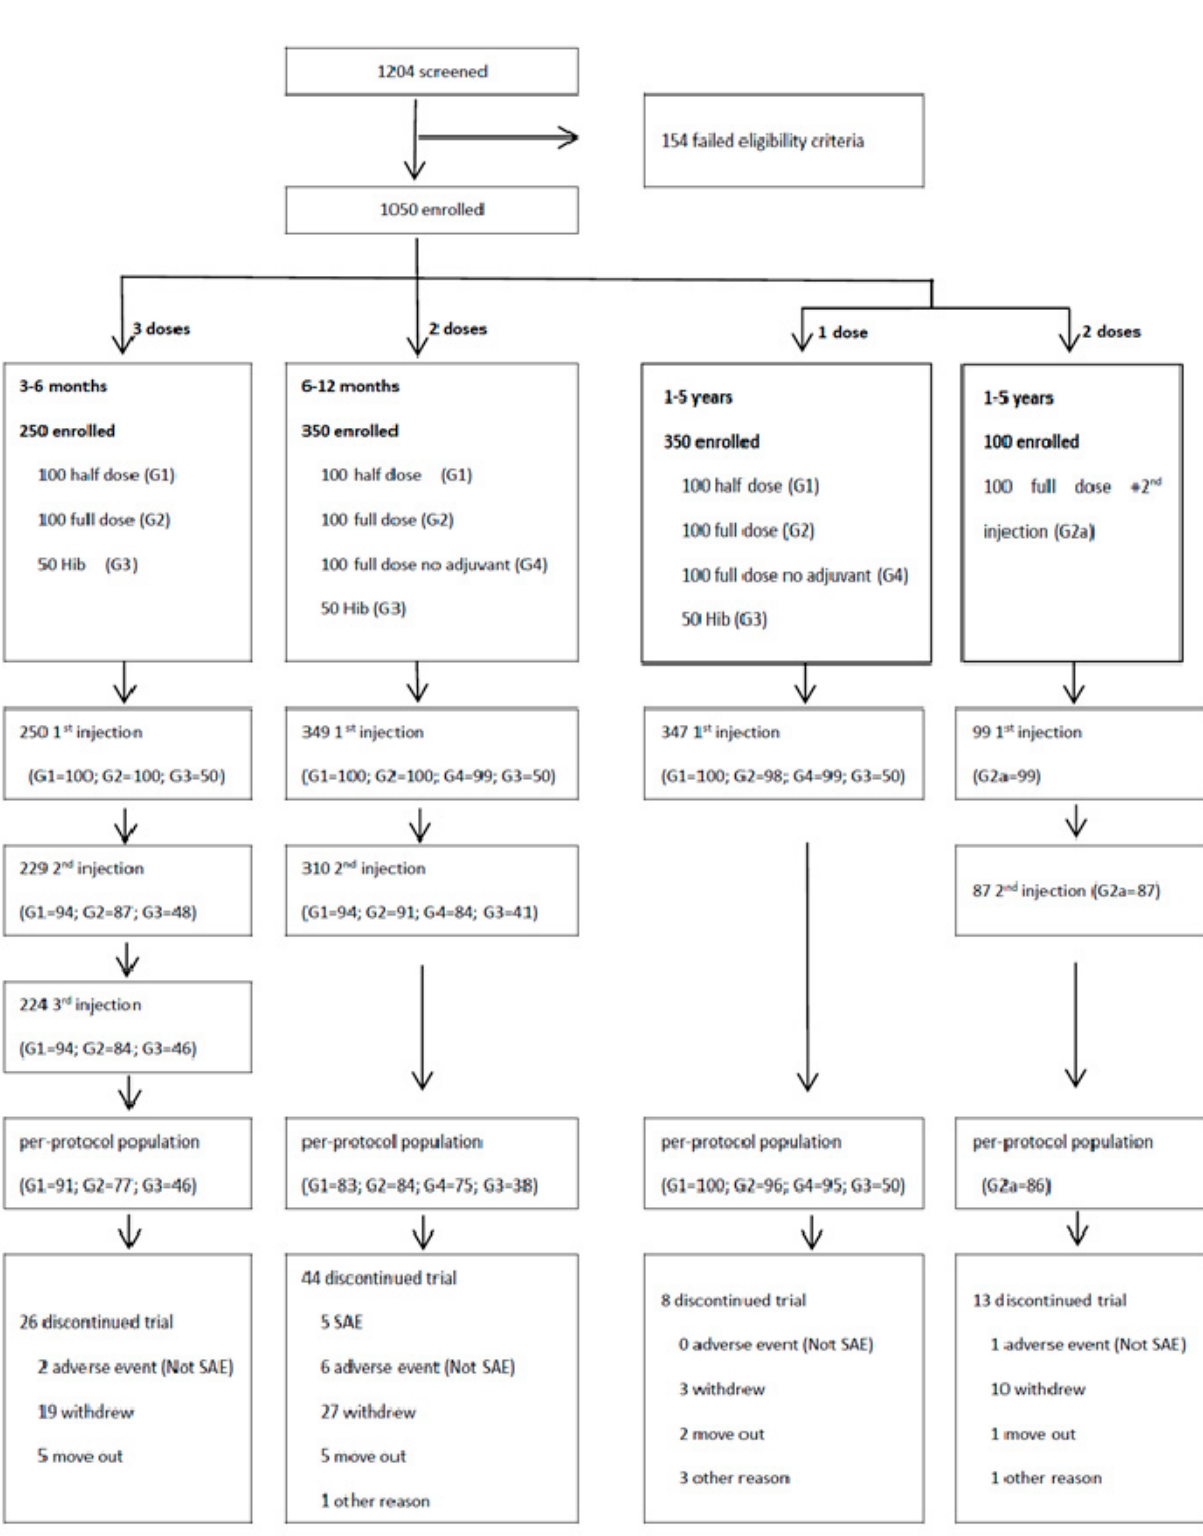
Figure 1. Study profile: subject randomization, screening, enrollment, and vaccine assignment of Phase II study of ZF0901 trial. SAE: serious adverse event.